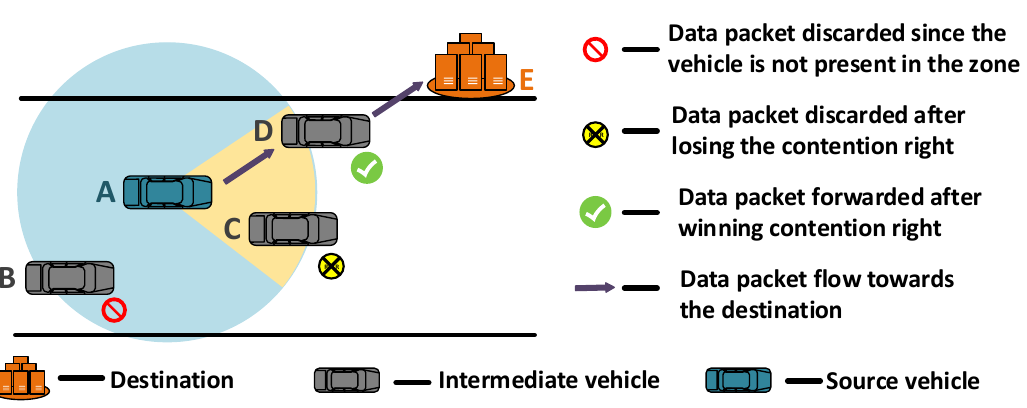
Figure 1. Illustration of a receiver-based forwarding scheme in